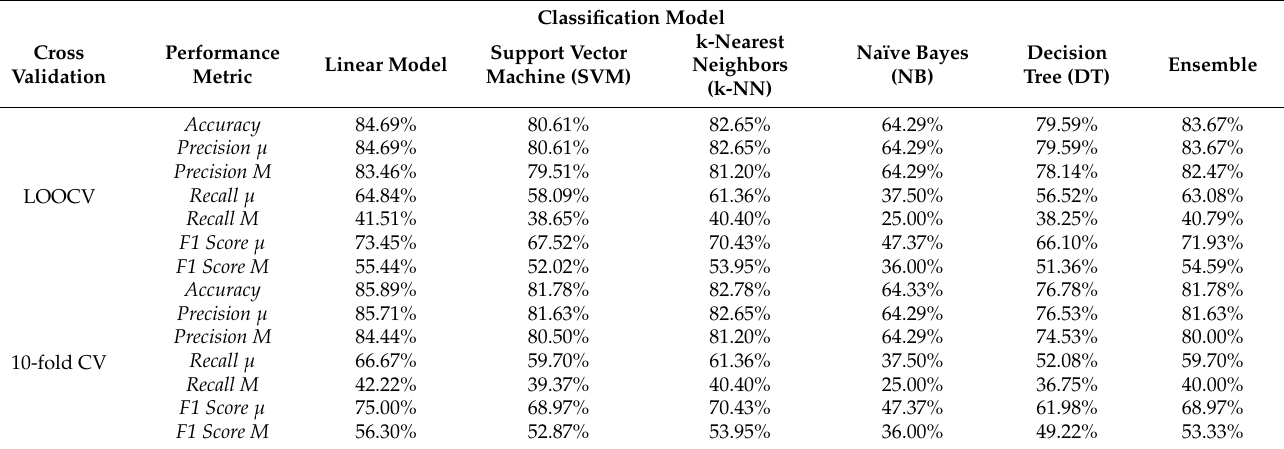
Table 7. Classification Results with MRMR feature selection using, respectively, LOOCV and 10-fold Cross Validation (2 classes).